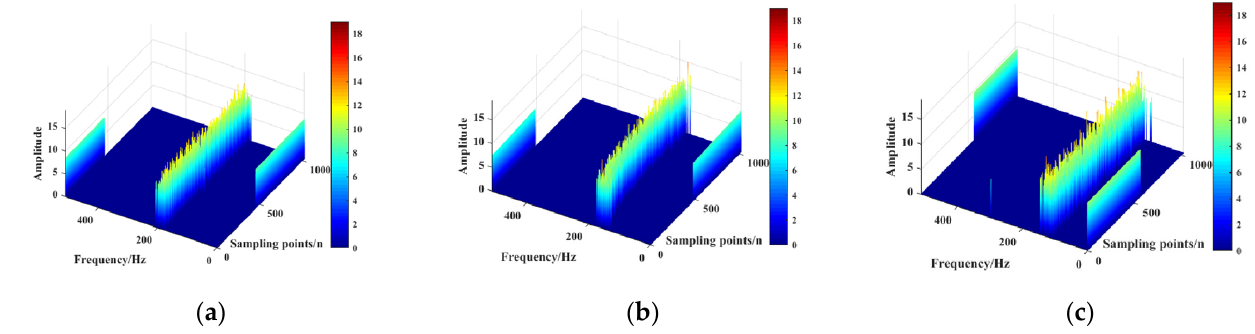
Figure 5. HHT time–frequency diagram of centrifugal pump vibration signal under ( a ) slight cavitation, ( b )severe cavitation, and ( c ) loose foot.